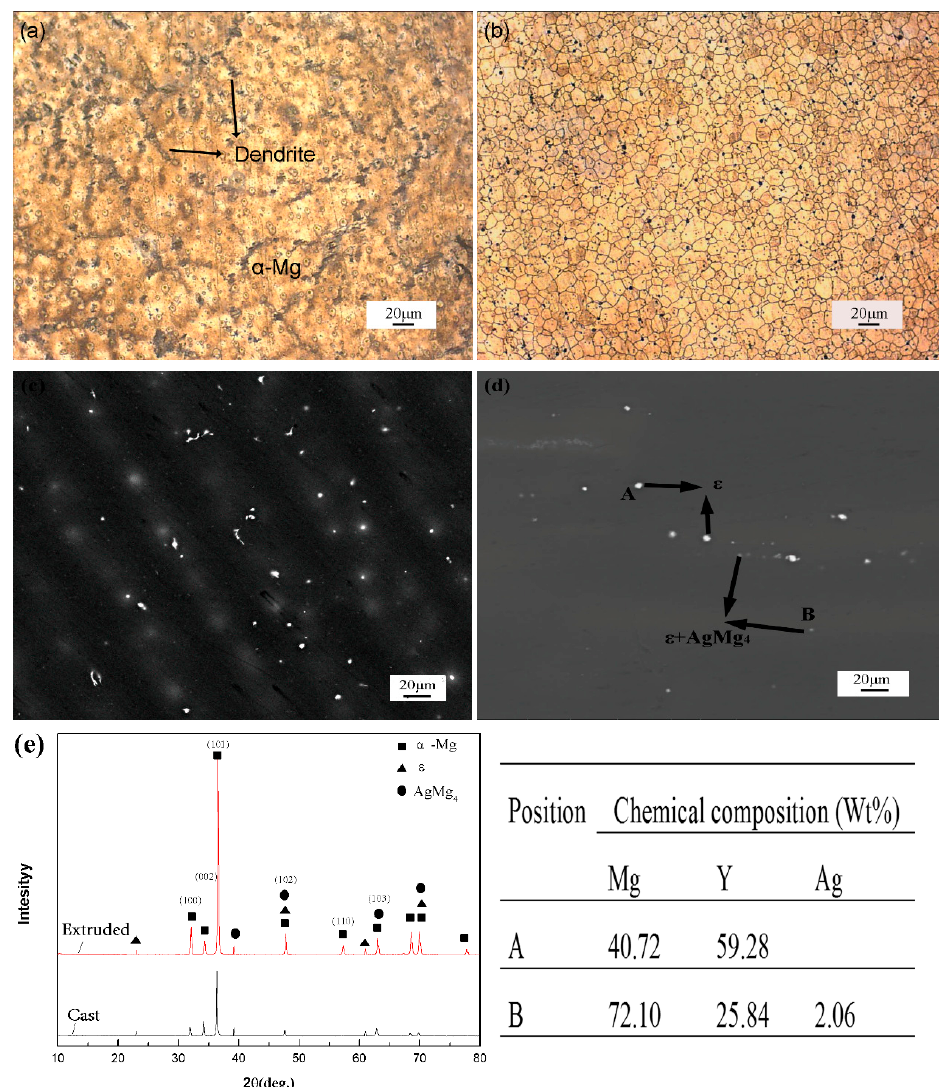
Figure 1. The microstructure and XRD patterns of Mg ‐ 4Y ‐ 1Ag alloys: ( a ) optical image of as ‐ cast ( b ) optical image of as-extruded alloys; ( c ) SEM image of as-cast alloy; ( d ) SEM image of as-extruded alloys; ( b ) optical image of as ‐ extruded alloys; ( c ) SEM image of as ‐ cast alloy; ( d ) SEM image of as ‐ alloys; and ( e ) XRD patterns and EDX analysis of Mg-4Y-1Ag extruded alloys; and ( e ) XRD patterns and EDX analysis of Mg ‐ 4Y ‐ 1Ag alloys.